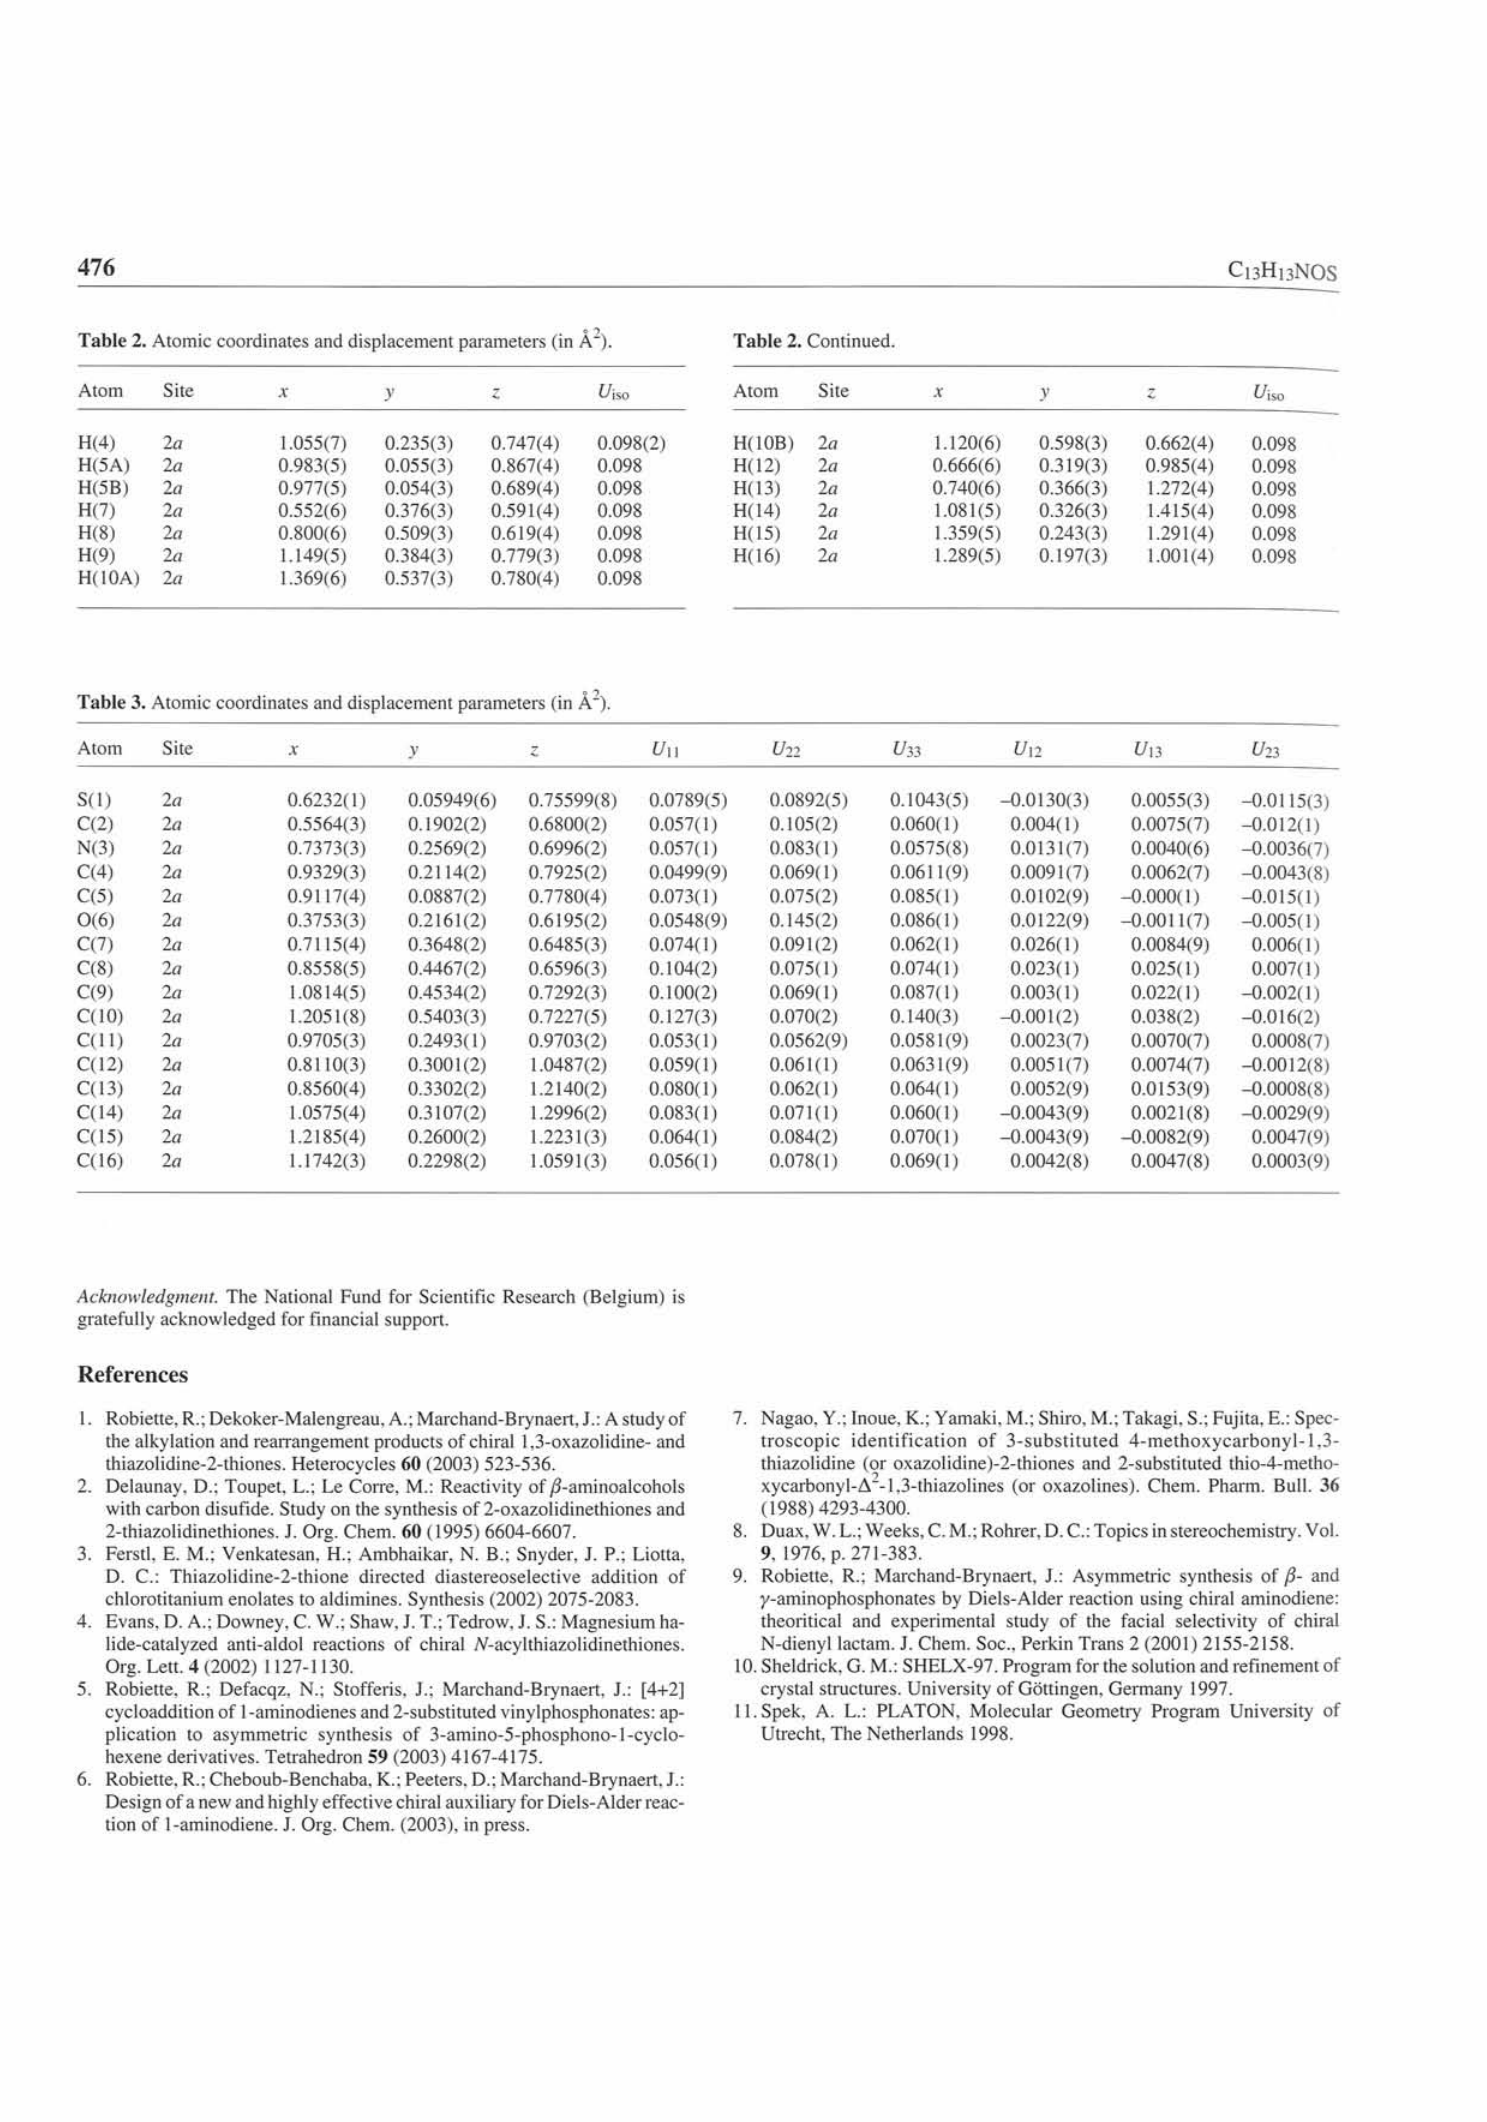
Table 3. Atomic coordinates and displacement parameters (in Â 2